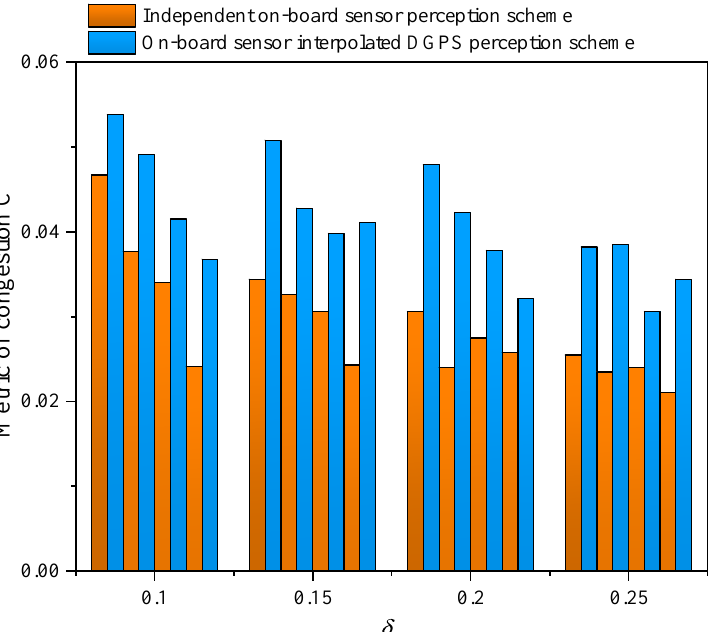
Figure 10. The metric of congestion function for varying perceptual error size δ with an independent on-board sensor perception scheme and an on-board sensor interpolated DGPS perception scheme in a partial CAV scenario. The data correspond to 80%, 60%, 40%, and 20% CAV penetration from left to right at each δ